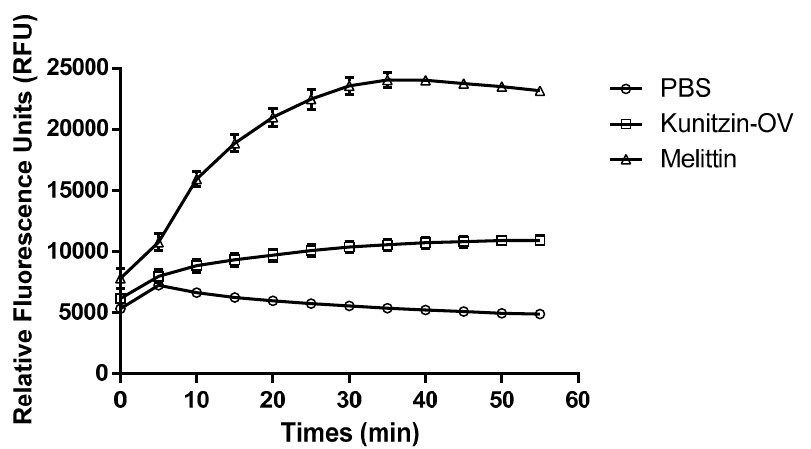
Figure 5. The cell membrane permeability of Kunitzin-OV with phosphate-buffered saline (PBS) as a negative control and melittin as a positive control.